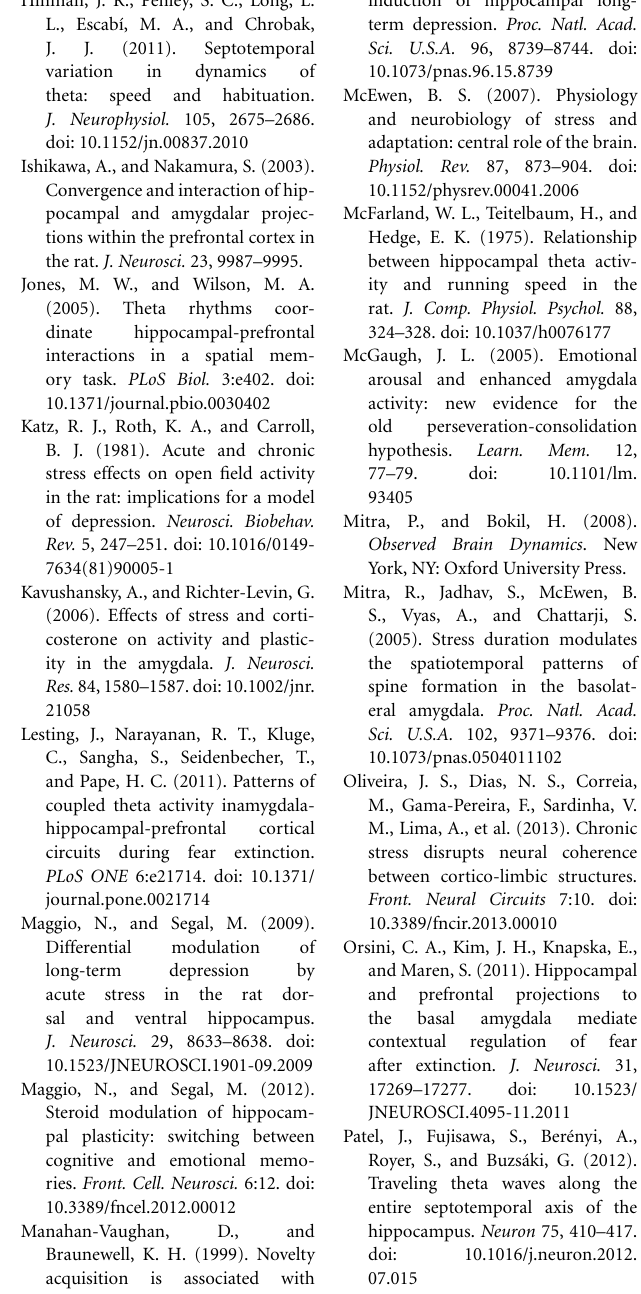
sites are marked as green crosses. PL, prelimbic area of PFC; IL, infralimbic area of the mPFC; BLA, basolateral amygdala. Diagrammatic coronal sections are adapted from Paxinos and Watson (2006). (B) Representative histological sections showing electrolytic lesions in mPFC (left), dHPC (middle-left), vHPC (middle-right), and BLA (right). Black arrows mark electrode